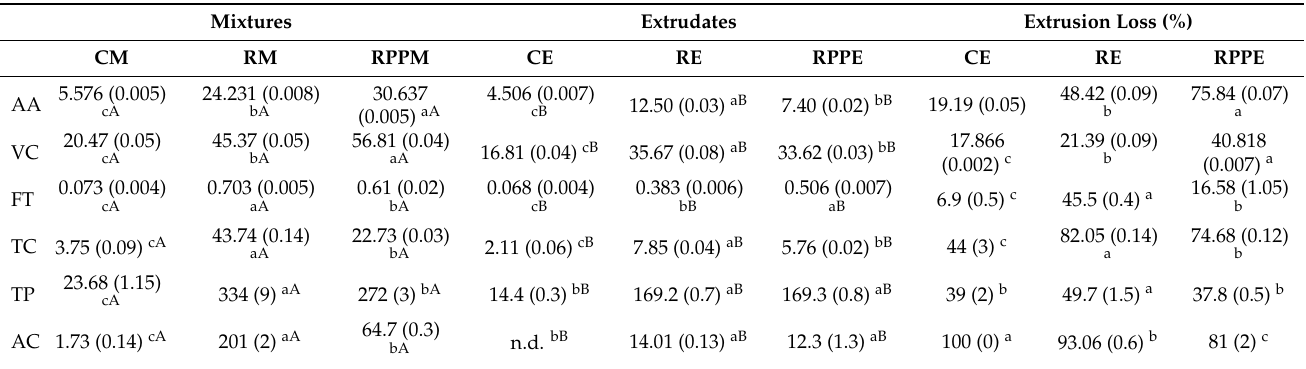
Table 4. Mean values (and standard deviations) of corn mixtures and extrudates’ component content and extrusion loss.